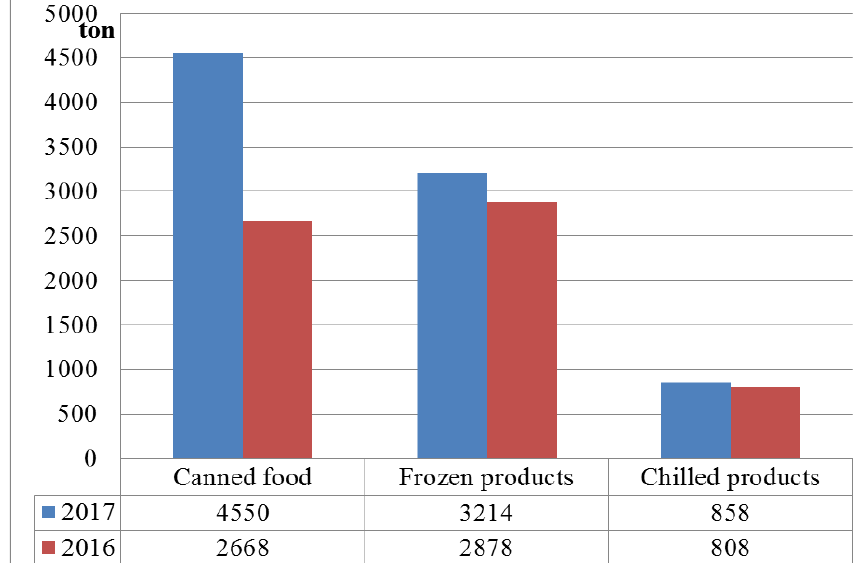
tons), Belarus (852 tons), Georgia (846 tons), Denmark (825